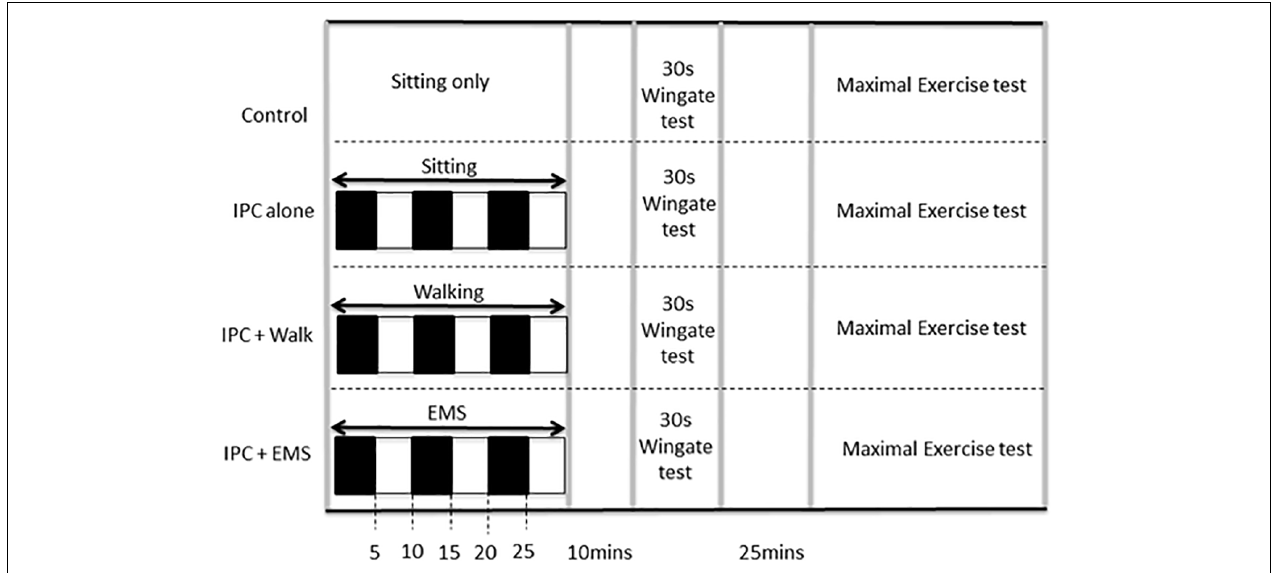
FIGURE 1 | Study protocol including experimental and control visits, which were performed in random order. IPC ischemic preconditioning, EMS electrical muscle stimulation. Black boxes represent arterial occlusion on both the right and left leg, white boxes represent no